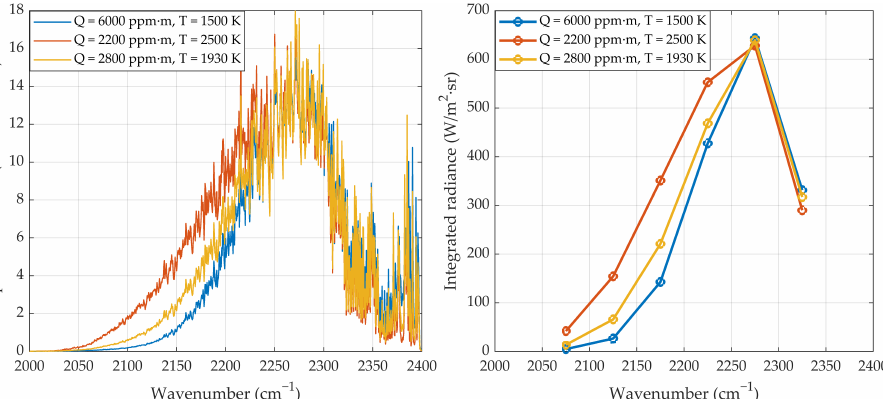
Figure 3. Left : Three simulated emission spectra for different column densities Q of CO 2 and flame temperatures. Right : Integrated radiances over spectral bands of 50cm − 1 width for the same high − resolution spectra of the left. (Figure previously published in